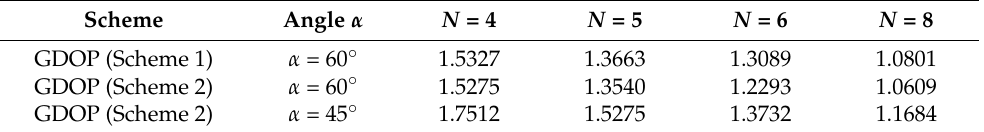
Table 1. The GDOP of different configurations for non-orthogonal gyro array ( ρ = 0).